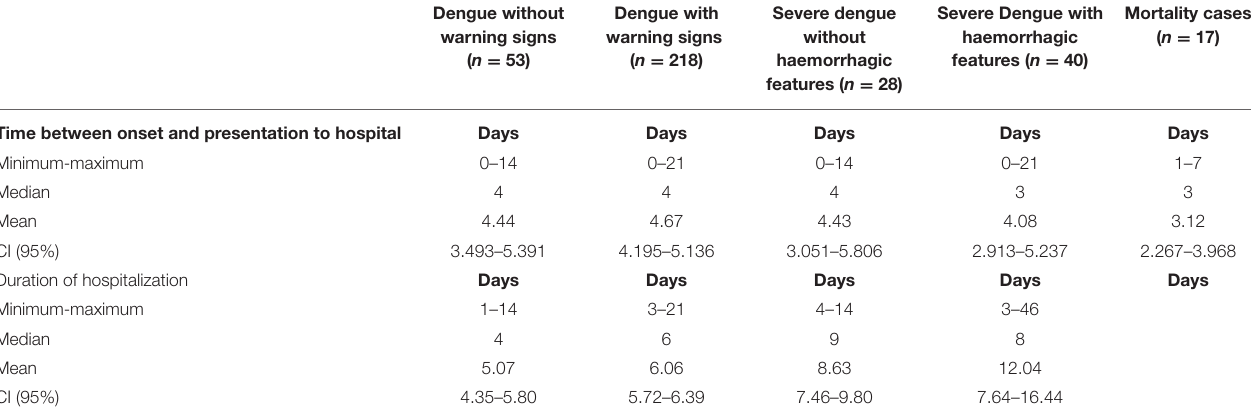
TABLE 2 | Time of presentation and duration of hospitalization in pediatric patients hospitalized with suspected and confirmed dengue in the 2018–2019 epidemic. Dengue without warning